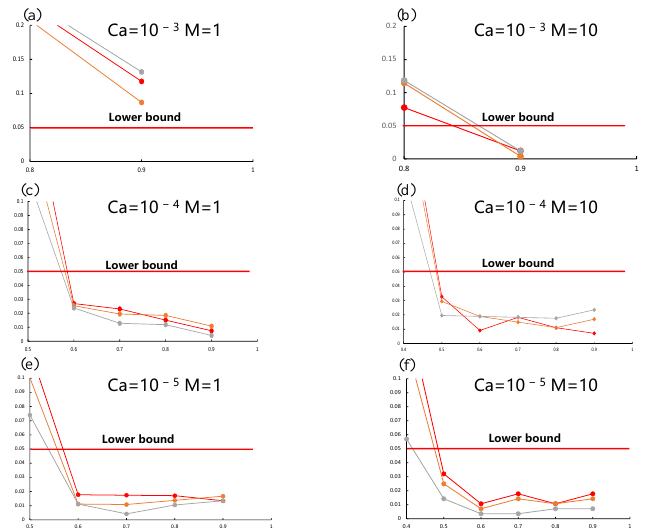
Figure 17. A close-up view of CO 2 relative permeability curves under 18 scenarios at Table 1 by narrowing the scope of brine saturation within which most of the values have fallen into the scale of 0.1. A lower bound value of k rCO2 = 0.05, as the minimum value for assuming the flow of CO 2 through the computational domain is present, is defined; therefore, brine saturations at which the CO 2 relative permeability firstly falls below the 0.05 are considered approximate maximum brine saturation ( S Brinemax ) in the computational domain where CO 2 residual saturation ( S residualCO2 ) is consequently estimated using Equation (26). (Note: ( a ) and ( b ) represent cases under high capillary number ( Ca = 1 × 10 − 3 ), while those under low capillary numbers ( Ca = 1 × 10 − 4 , Ca = 1 × 10 − 5 ) are done by ( c – f